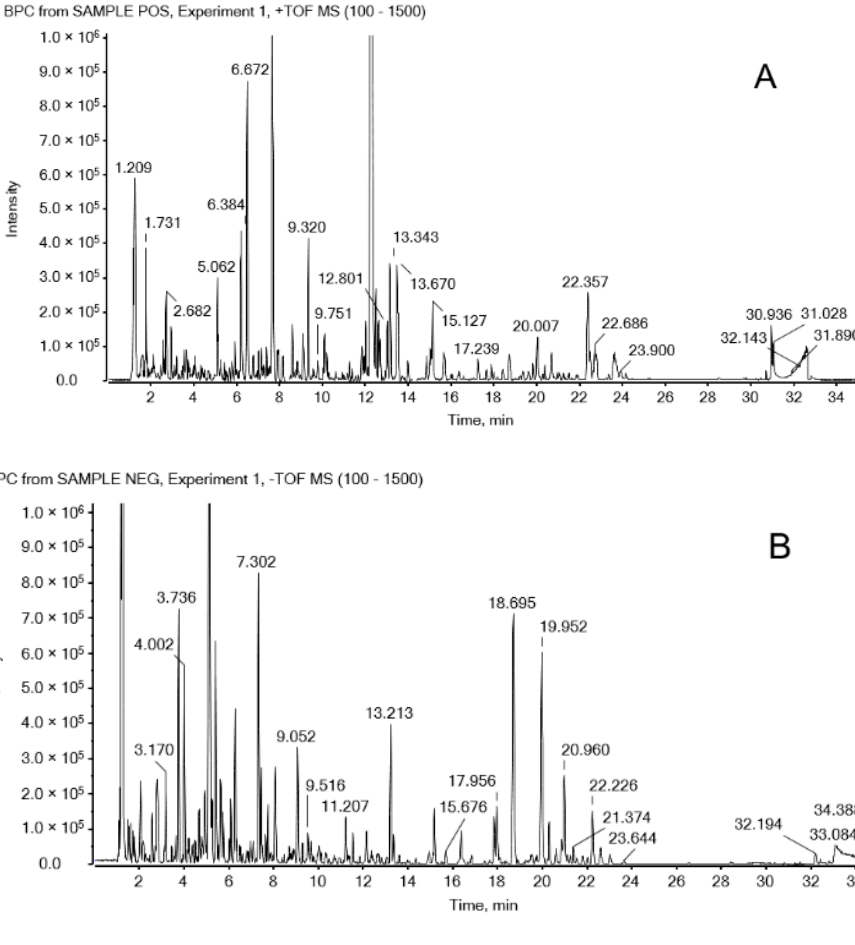
Figure 1. Cont Figure 1. Cont.